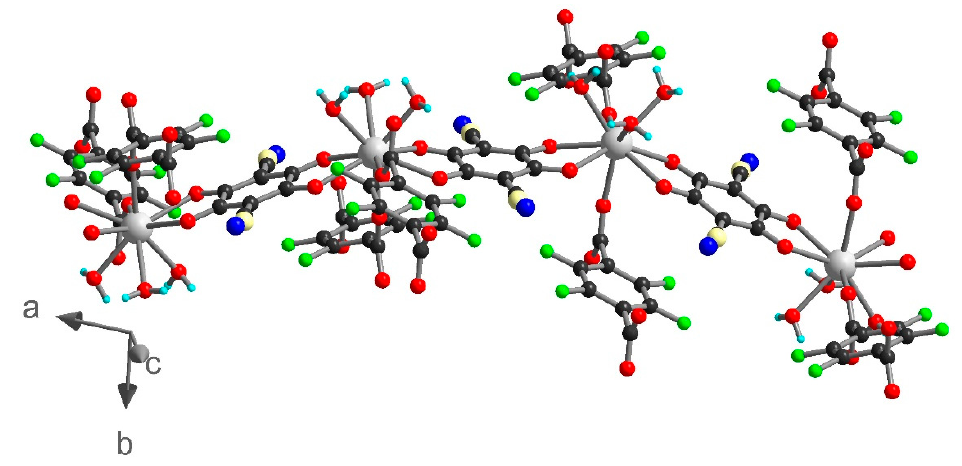
Figure 5. 1D chain of Eu-ClCNAn 2 − connected by F 4 BDC 2 − ligands in 3 . Color code: C (black), H (cyan), O (red), N (blue), F (green), Cl (light yellow), Eu (grey).